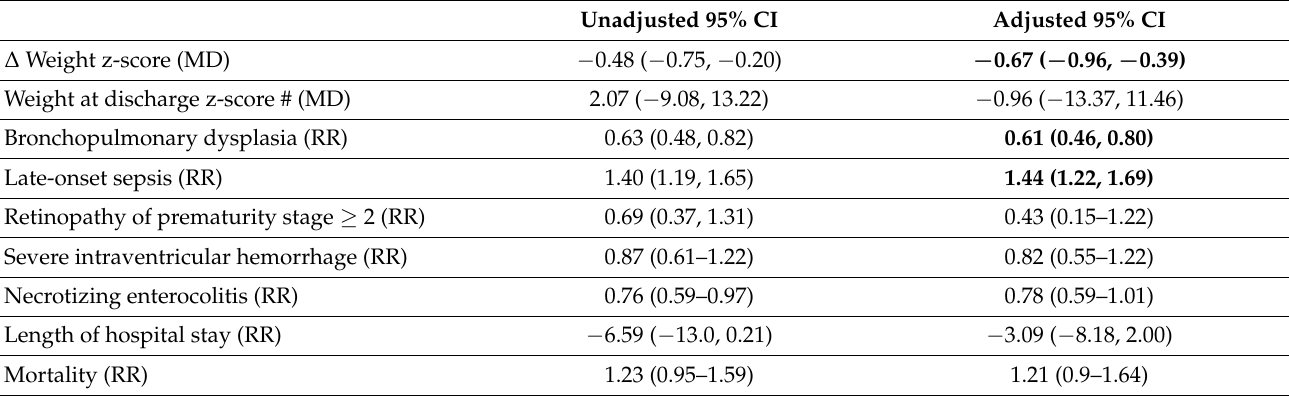
Table 4. Multivariable regression for infant’s outcome stratified by type of LE.